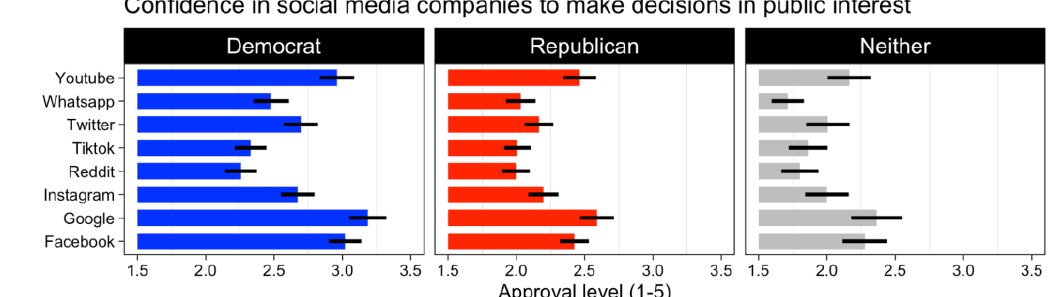
Figure 7. Trust in specific social media platforms by party. This grid shows mean confidence – 1.96 standard errors measured on a 6-point scale (x-axis) in specific social media companies (y-axis), for each respondent group (columns). Across all groups, Google is marginally most trustworthy, while WhatsApp and TikTok are least so, though there are small